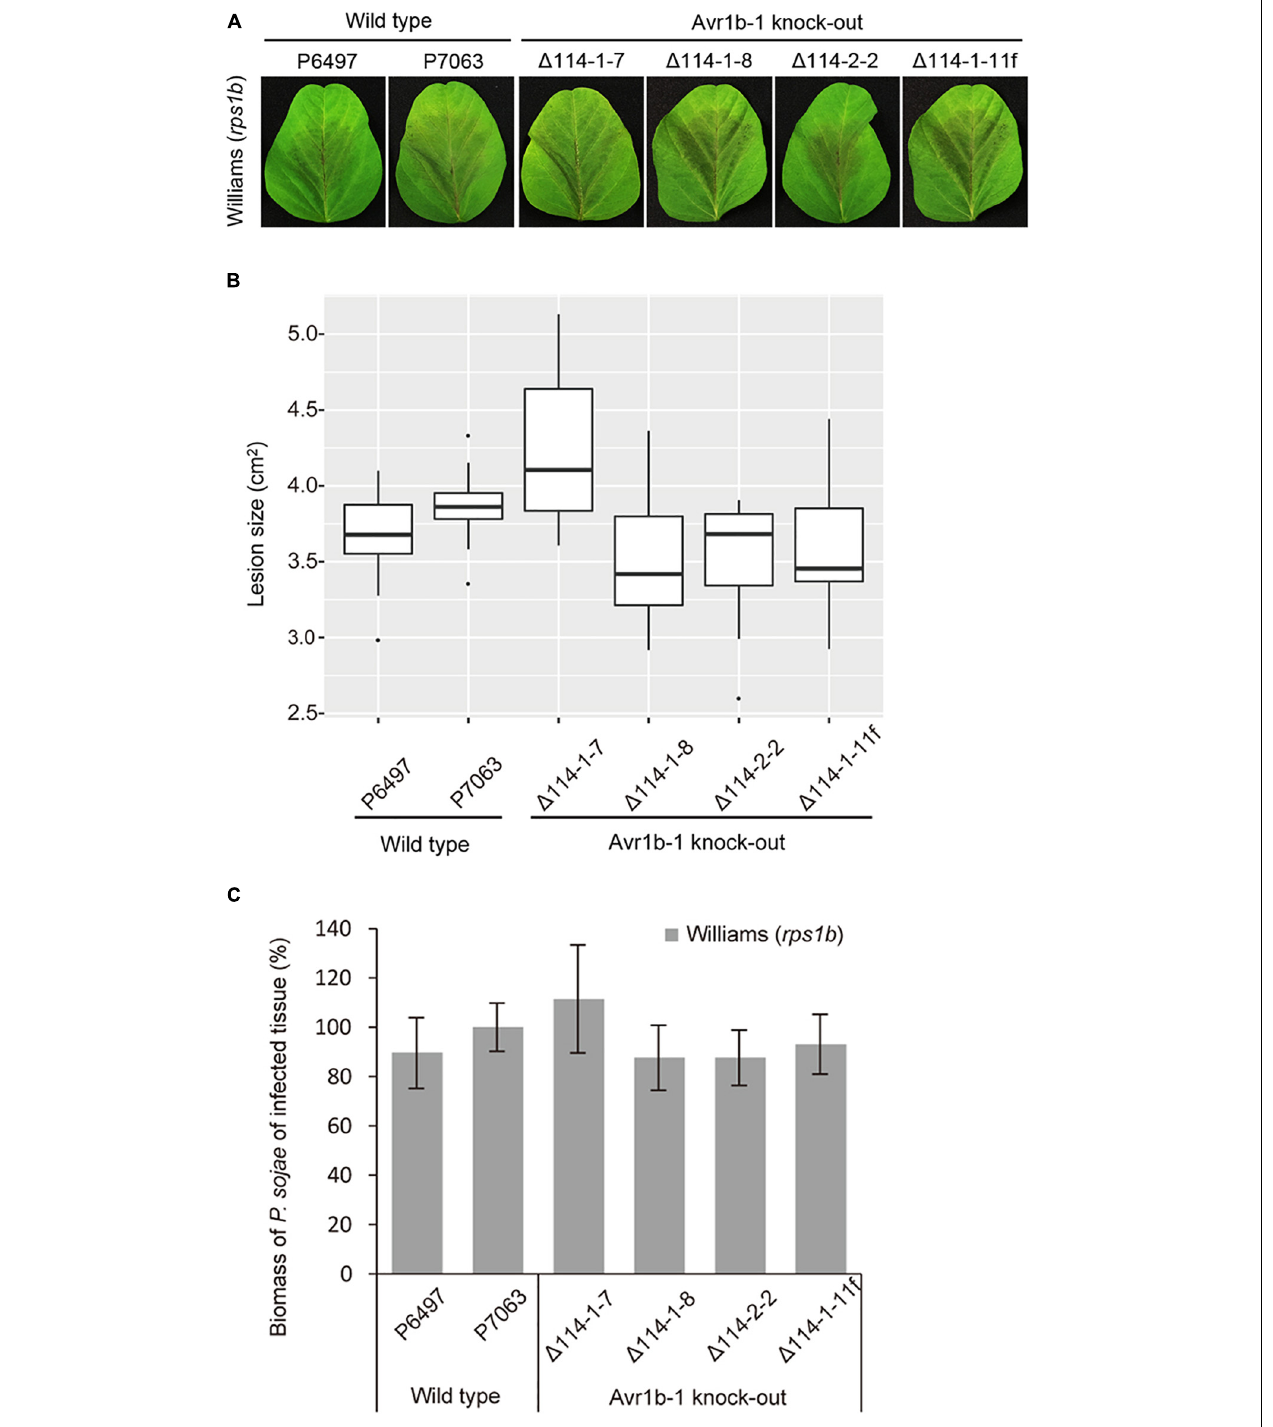
FIGURE 3 | Virulence phenotypes of Avr1b-1 knock-out transformants on Williams soybean leaves. (A) Avr1b-1 -silenced isolate P6497; Avr1b-1 -expressing isolate P7063; three homozygous Avr1b-1 deletion transformants (cid:49) 114-1-7, (cid:49) 114-1-8, and (cid:49) 114-2-2; plus non-HDR transformant (cid:49) 114-1-11f were inoculated onto unifoliate leaves of Williams ( rps1b ). Pictures were taken 3 days after inoculation. (B) Average lesion sizes determined from at least 10 inoculated unifoliate leaves in each of three independent experiments. The relative lesion sizes were measured by ImageJ software. Error bars represent the mean ± standard deviation. P -values were determined by the Wilcoxon rank sum test. (C) Virulence phenotypes of Avr1b-1 knock-out transformants measured by real-time PCR-based quantification of P. sojae genomic DNA in infected tissue. Error bars represent standard deviation of three technical replicates. This experiment was replicated three times. Error bars represent the mean ± standard